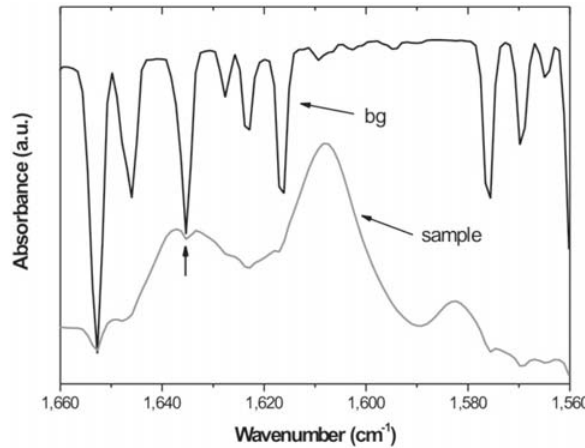
FIGURE 2- Deformed absorption spectrum of dental composite sample (bottom) and the background (bg) spectrum (top) showing the presence of water absorptions (a.u.= arbitrary units)